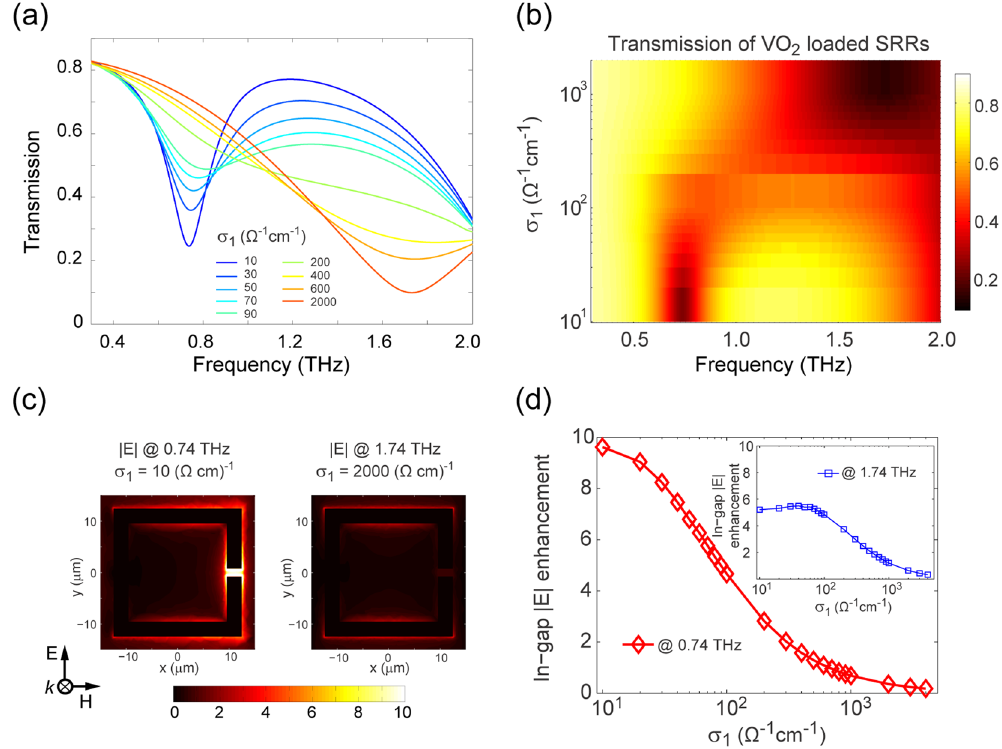
Figure 2. Active performance of the THz metamaterial consisting of an array of SRRs with VO 2 loaded in their gaps. ( a ) Simulated transmission spectra for a series of VO 2 conductivity ( σ 1 ) values. ( b ) A semi-log two-dimensional plot of the transmission spectra. ( c ) The electric field distribution for the first resonance at 0.74 THz when σ 1 = 10 Ω − 1 cm − 1 and the second resonance at 1.74 THz when σ 1 = 2000 Ω − 1 cm − 1 . ( d ) The in- gap electric field enhancement as a function of σ 1 at 0.74 THz. The field enhancement at 1.74 THz is shown in the inset. All data for |E| was normalized to the electric field magnitude of the incident